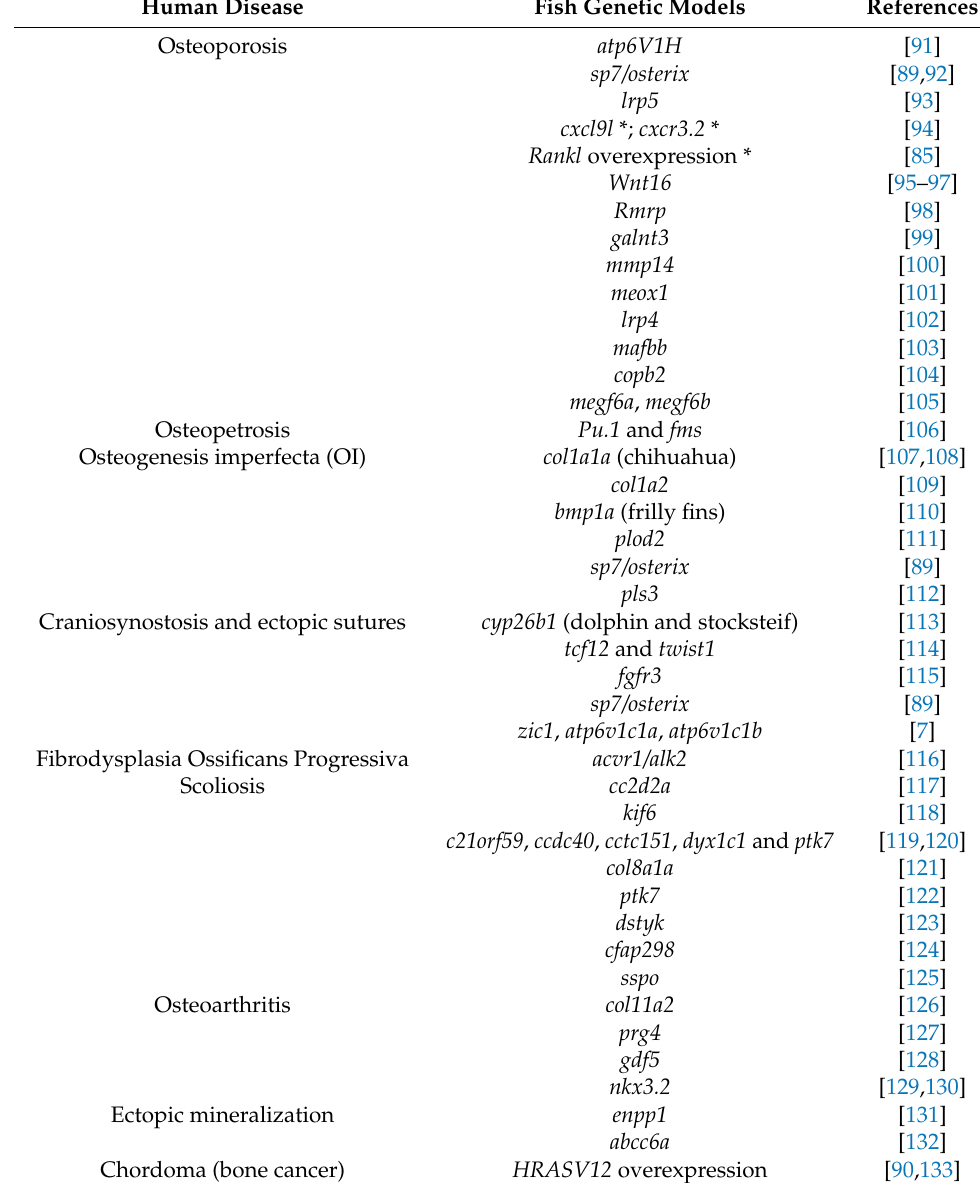
Table 2. Fish genetic models for human skeletal diseases. Human